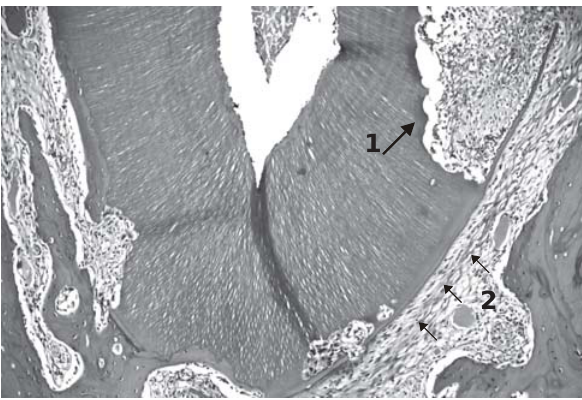
FIGURE 6- Group III. Extensive root resorption areas (1). Periodontal ligament covering the healthy root cementum layer, with PDL fibers oriented parallel to the cementum surface (2). Hematoxylin-eosin (original magnification